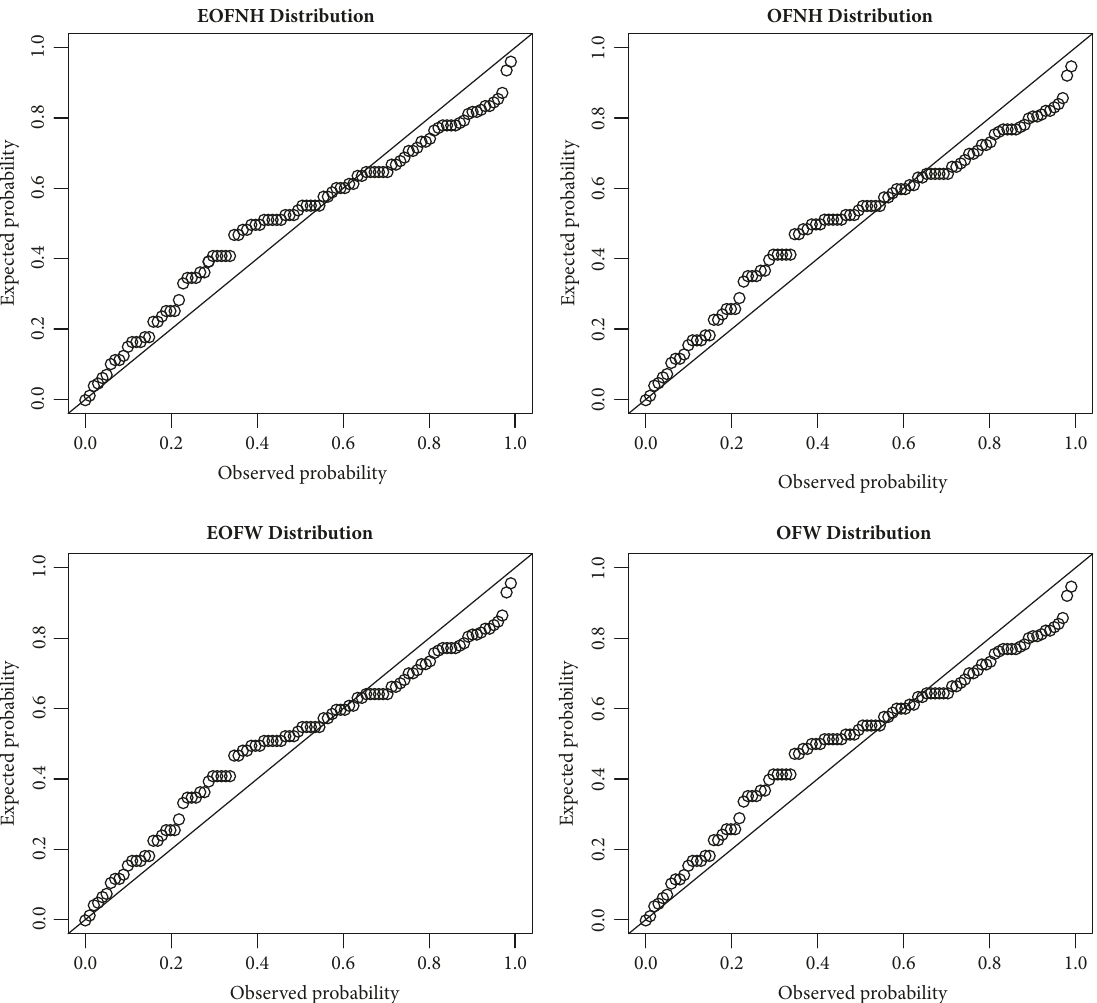
Figure 6: P-P plots of fitted